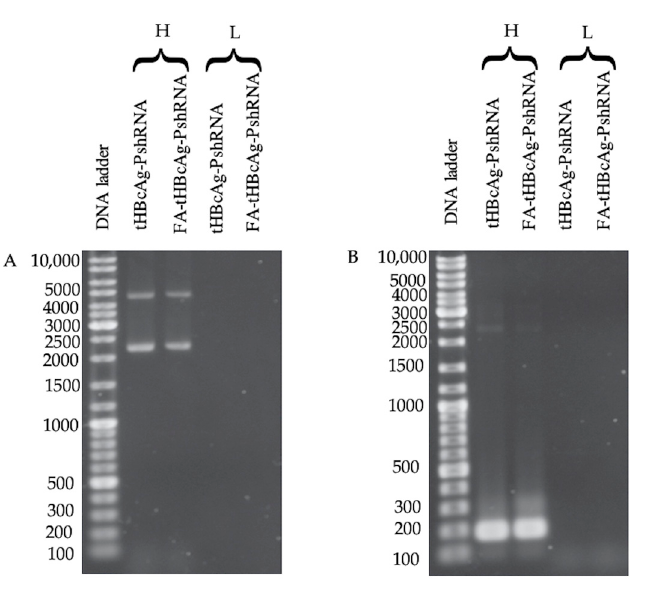
Figure 3. Identification of plasmid PshRNA containing Bcl ‐ 2 insert in tHBcAg VLPs. The VLPs from the heavier density peak (H, Figure 2) and lighter density peak (L, Figure 2) were extracted using the alkaline lysis method. Plasmid PshRNA ( A ), and the PCR product of the Bcl ‐ 2 insert ( B ) were analysed on 1% agarose gel. tHBcAg ‐ PshRNA (PshRNA packaged with truncated hepatitis B